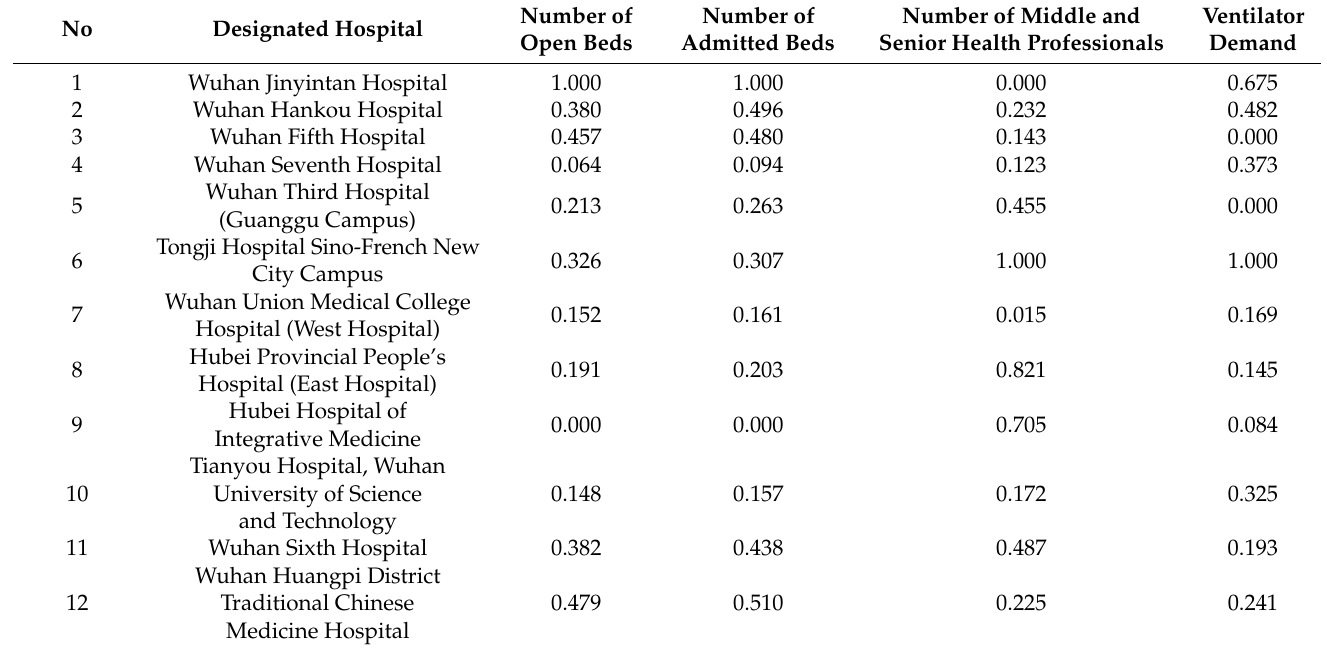
Table 6. Standardized information for each medical equipment demand point.